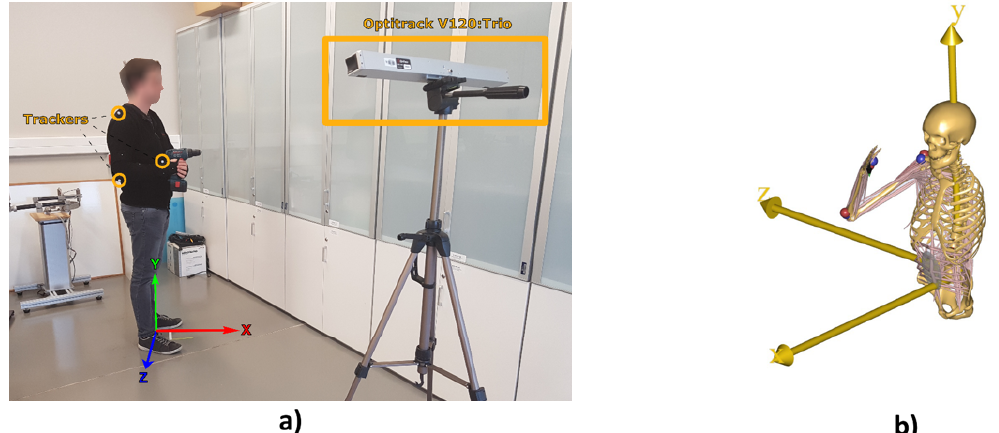
Figure 3. Recording of trajectories simulating one of the tasks to be performed by the operator, where ( a ) shows the setup for recording the trajectories and ( b ) the AnyBody TM model replicating the movements. The participant that appears in the figure has provided written and informed consent for its